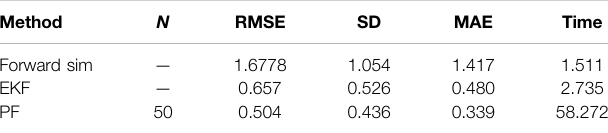
TABLE 4 | The performance of the Forward simulation, EKF, and PF during complete